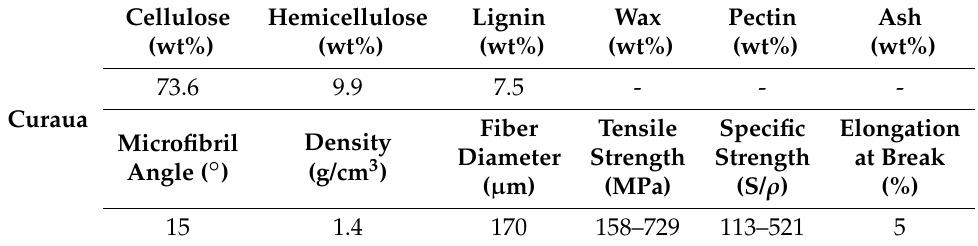
Table 1. Physical, chemical and mechanical properties of curaua fibers